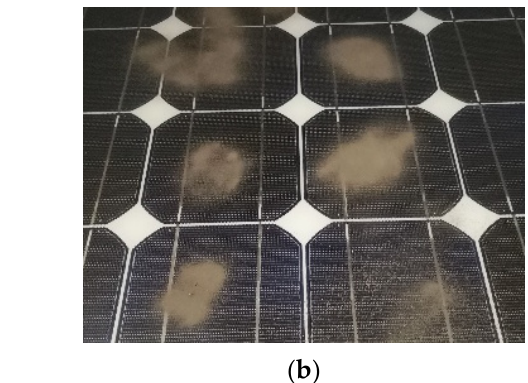
Figure 18. ( a ) Thermographic picture and ( b ) normal image of the solar panel.